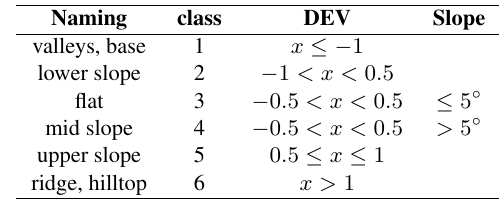
Table 4: Classification rules - 6 classes, adapted from (Jenness,